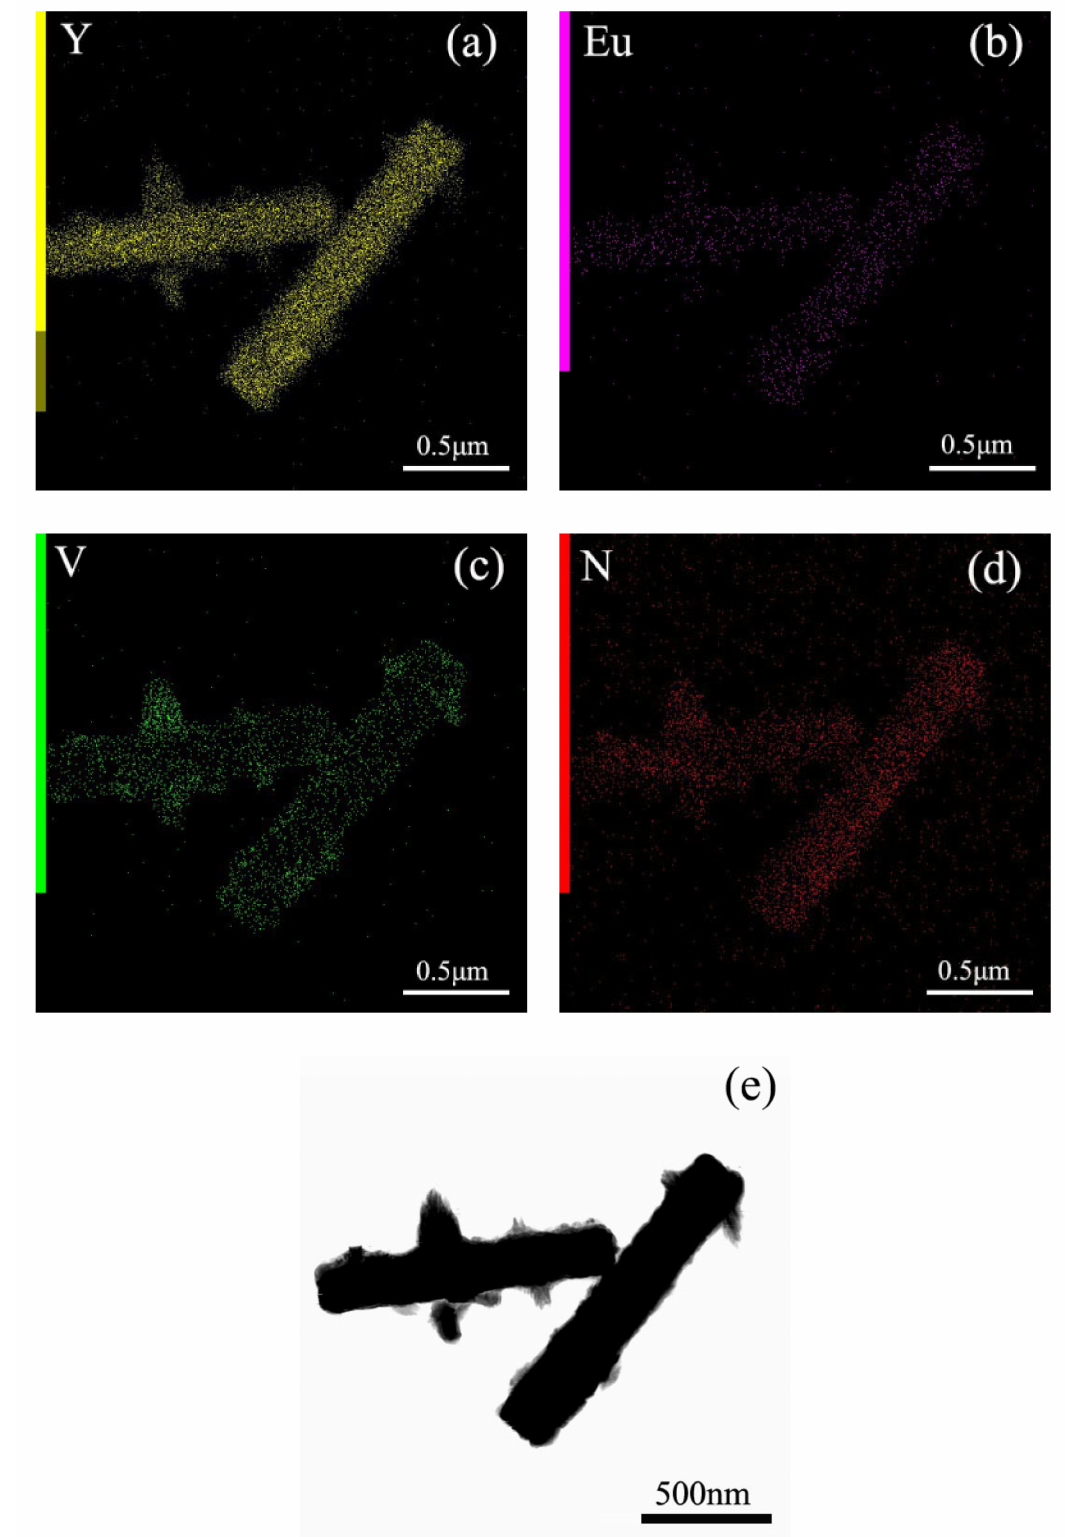
Figure 7. ( a – d ) Elemental mapping and ( e ) TEM image for MC-1.5V. Figure 8 shows the PLE and PL spectra for MC. By monitoring the 5 D 0 → 7 F 2 emission at 617 nm, a series of sharp lines in the PLE spectrum ranging from 300 nm to 500 nm can be ascribed to the transitions within the Eu 3+ 4f 6 electronic configuration.